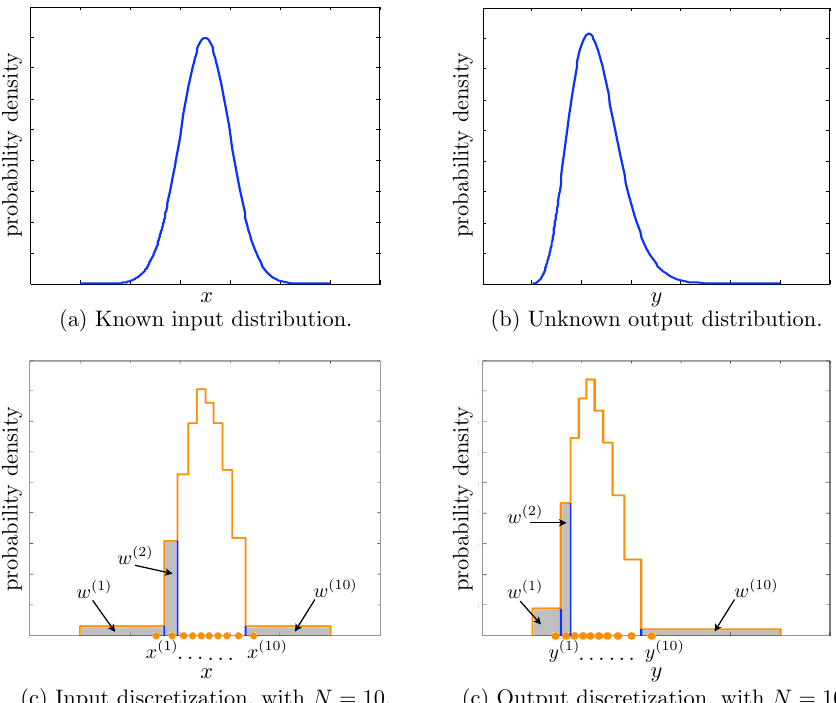
Fig. 1. Graphical representation of the first three steps of our strategy, with d = 1 and N = 10. The lower graphs represent the discrete approximations of the input and output probability distributions produced by the SQ method. The weight w (i) is the area of the rectangle associated to the i -th point for i = 1 ,...,N